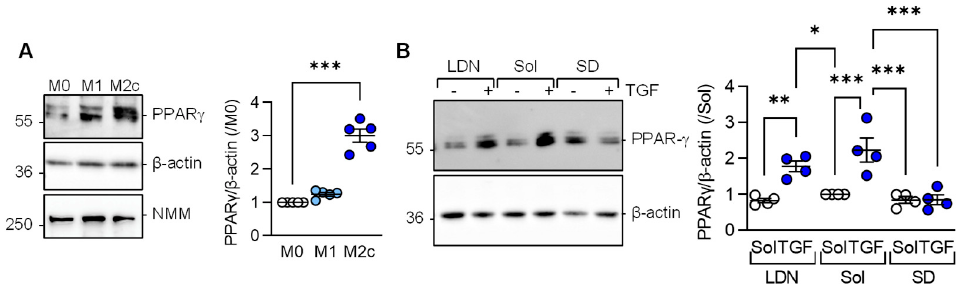
Figure 3. TGF- β -regulated PPAR- γ expression depends on the activation of Alk5. ( A ) Expression of PPAR- γ in M0, M1, and M2c polarized macrophages from wild-type mice; n = 5 independent experiments (Kruskal–Wallis test followed and Dunn’s multiple comparisons test). Non muscle myosin (NMM) was included as an additional loading control. ( B ) Expression of PPAR γ in M1 polarized murine macrophages treated with solvent (0.1% DMSO), the Alk1 inhibitor; LDN193189 (100 nmol/L), or the Alk5 inhibitor; SD208 (500 nmol/L) for 2 h prior to the addition of TGF- β for M2c polarization; n = 4 independent experiments/group (two way ANOVA and Sidak’s multiple comparisons test). * p < 0.05, ** p < 0.01, *** p < 0.001.